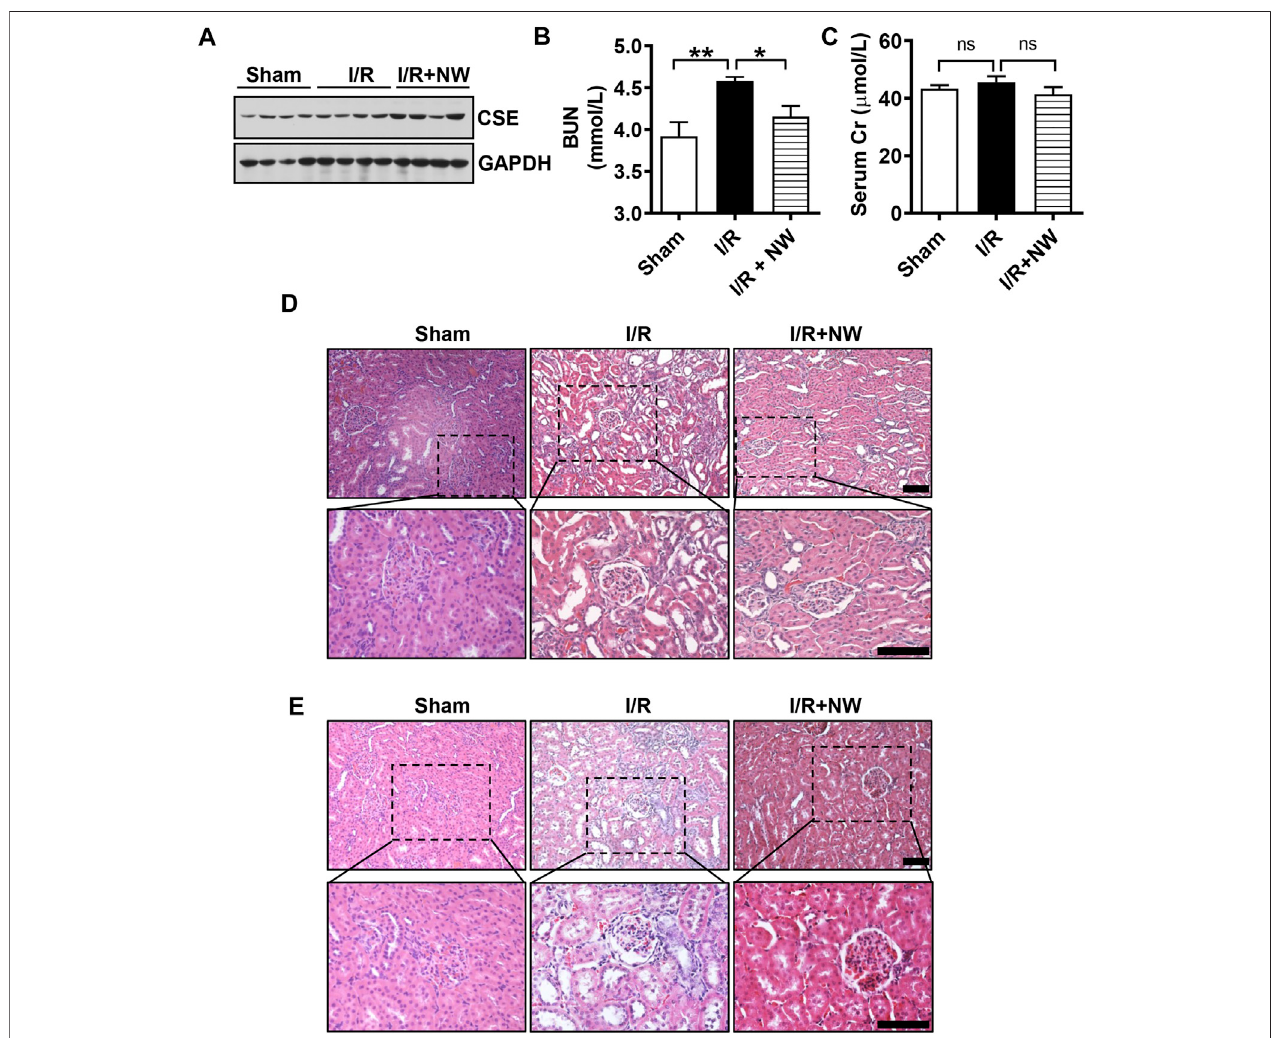
FIGURE 5 | NW plays a long-term protective role in kidney ischemia – reperfusion injury. 1 h after kidney ischemia and 2 weeks after reperfusion, western blot analyzestheCSEprotein level (A) .Bloodureanitrogen (B) andserum Cr(creatinine) (C) contentsinsham, I/R,andI/R +NWgroups.H&Estainingofthekidney1 hafter kidneyischemiaand 2 weeksafter reperfusion (D) ,scalebar (cid:2) 100 μ m. H&Estainingofthekidney 1 hafter kidneyischemiaand 4 weeks afterreperfusion (E) ,scalebar (cid:2) 100 μ m. N (cid:2) 6/group. * p < 0.05, ** p < 0.01. ns: no signi fi cant difference.